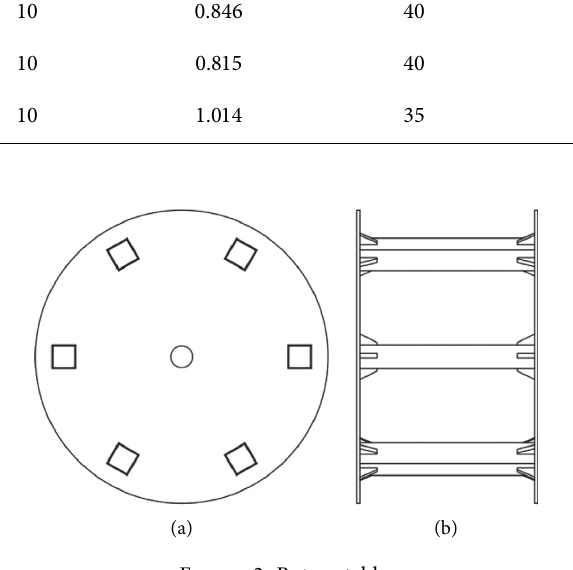
Figure 2: Rotary table.